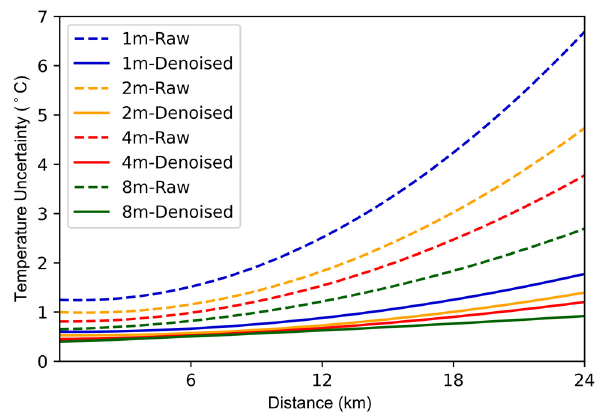
Figure 12. Temperature uncertainty with different averaging times.